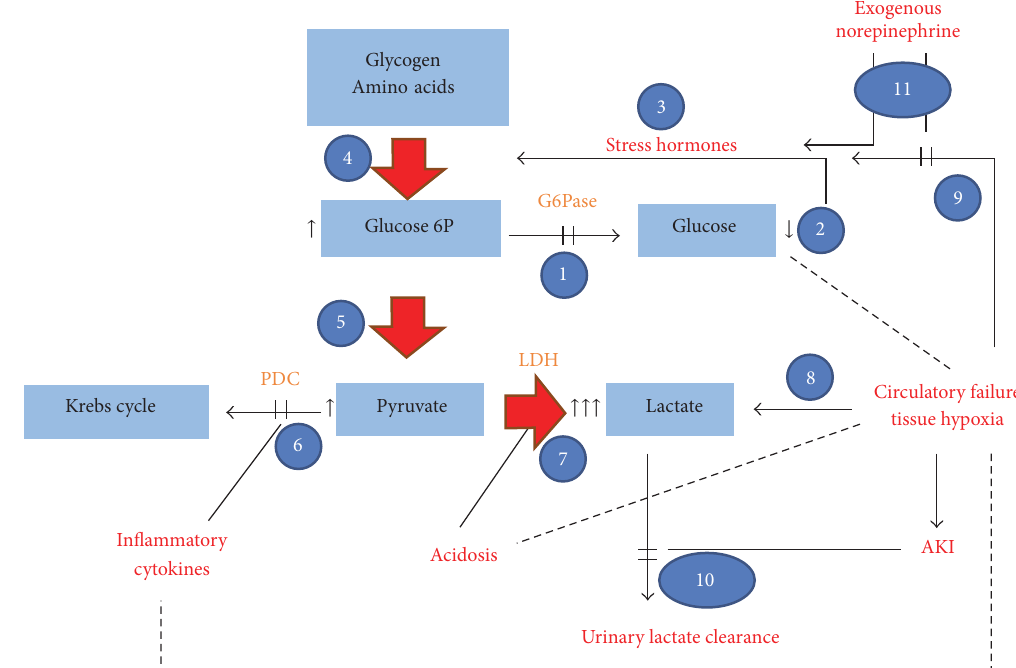
Figure 2: Suggested scheme of altered metabolic pathways and physiologic changes in the case report, leading to extreme hyperlactemia.The inherent disorder, nonfunctioning G6Pase, blocks conversion of G6P to glucose (1). In the absence of continuous glucose supplementation, ensuing hypoglycemia (2) activates stress hormones (catecholamines, glucocorticoids, and glucagon) and suppresses insulin secretion (3). Consequently, glycogenolysis and gluconeogenesis are enhanced, with accelerated generation of glucose-6P (4), which, unable to convert to glucose, undergoes glycolysis with the generation of pyruvate (5). Since PDC is inhibited by PDH kinase, induced by cytokines such as TNF andbydepressedinsulin,shuntingpyruvatetotheKrebscycleisinhibited(6).Excesspyruvateisconvertedtolactate,especiallyinthepresence of acidosis and with increased G6P (7). A type A component of lactic acidosis results from circulatory failure and tissue hypoperfusion and hypoxia, further intensifying lactate generation (8), and stimulating the release of stress hormones (9). Finally, urinary clearance of excess lactate is hampered due to evolving kidney failure (10). Exogenous catecholamines for circulatory failure (11) may reduce type A lactate generation by the restoration of tissue perfusion in some organs but might intensify type B lactic acidosis via enhanced gluconeogenesis. Scattered lines represent reciprocal association. LDH: lactate dehydrogenase; G6P: glucose-6-phosphate; G6Pase: glucose-6-phosphatase; PDC: pyruvate dehydrogenase complex; PDH: pyruvate dehydrogenase; AKI: acute kidney